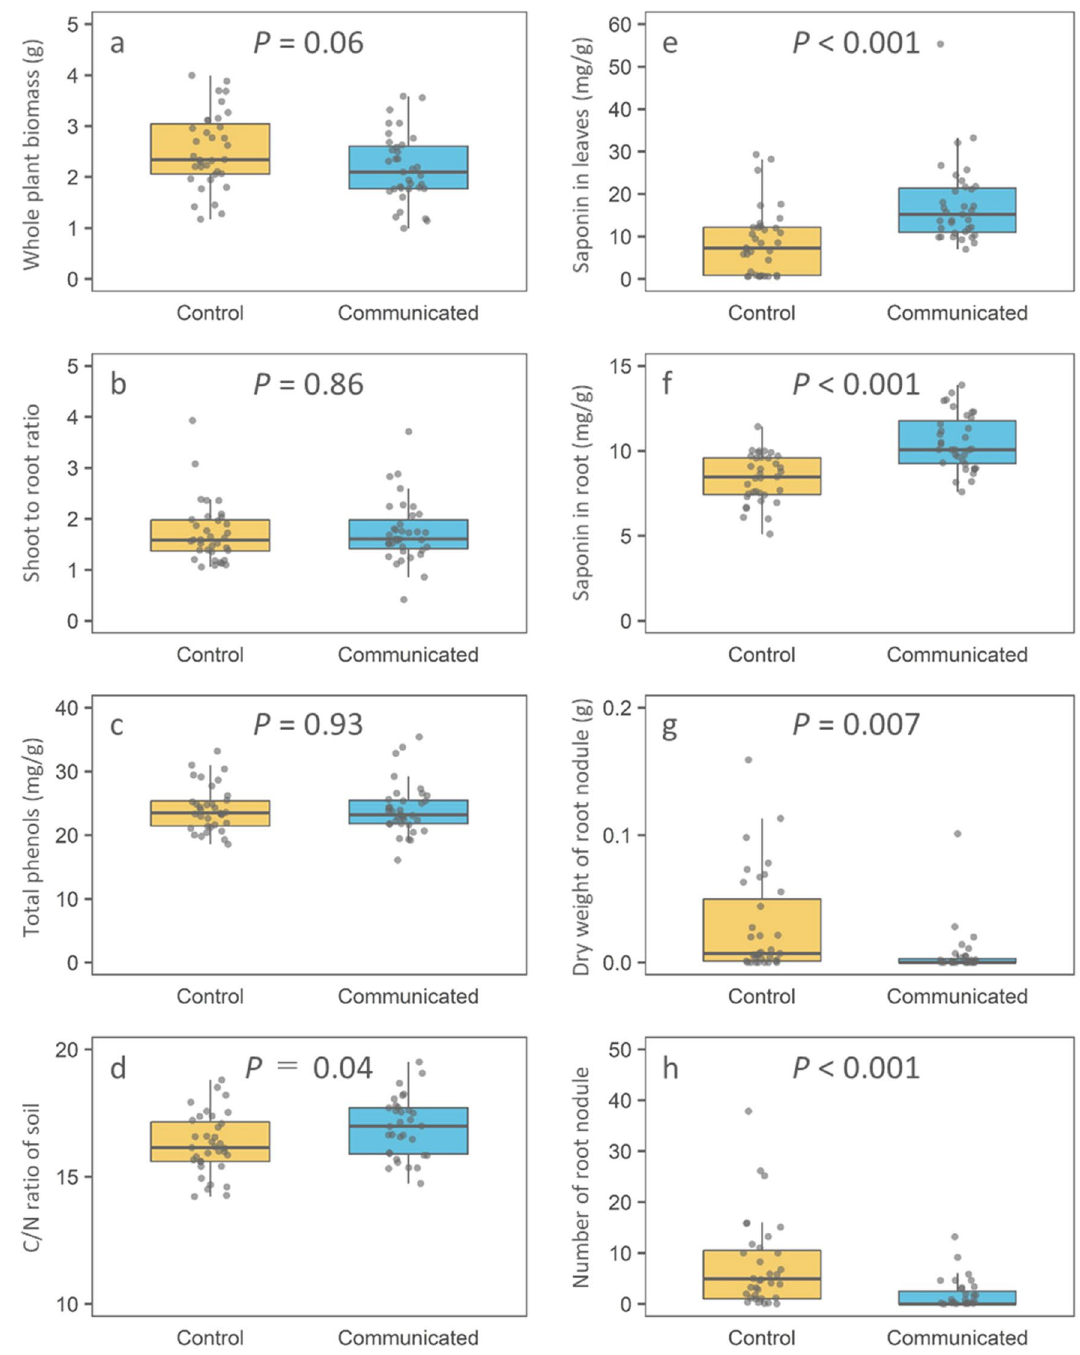
Figure 1. Growth, defense traits and root nodule symbiosis in soybean and soil nutrient concentration. ( a ) Whole plant biomass (g), ( b ) Shoot to root ratio, ( c ) total phenolics (mg g –1 ), ( d ) C/N ratio in soil, ( e ) saponin concentration in leaves (mg g –1 ), ( f ) saponin concentration in root (mg g –1 ), ( g ) dry weight of root nodules per plant (g), ( h ) number of root nodules per plant. Data are means ± SD (control, n = 35; communicated treatment plants, n = 35). P -values were corrected by the false discovery rate. Boxplots were plotted in R using the ggplot2